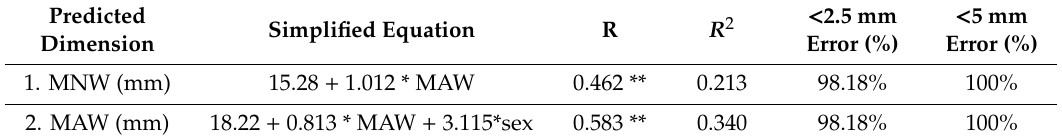
Table 6. Regression equations showing correlation coefficients (R) and linearity of relationship. Predicted